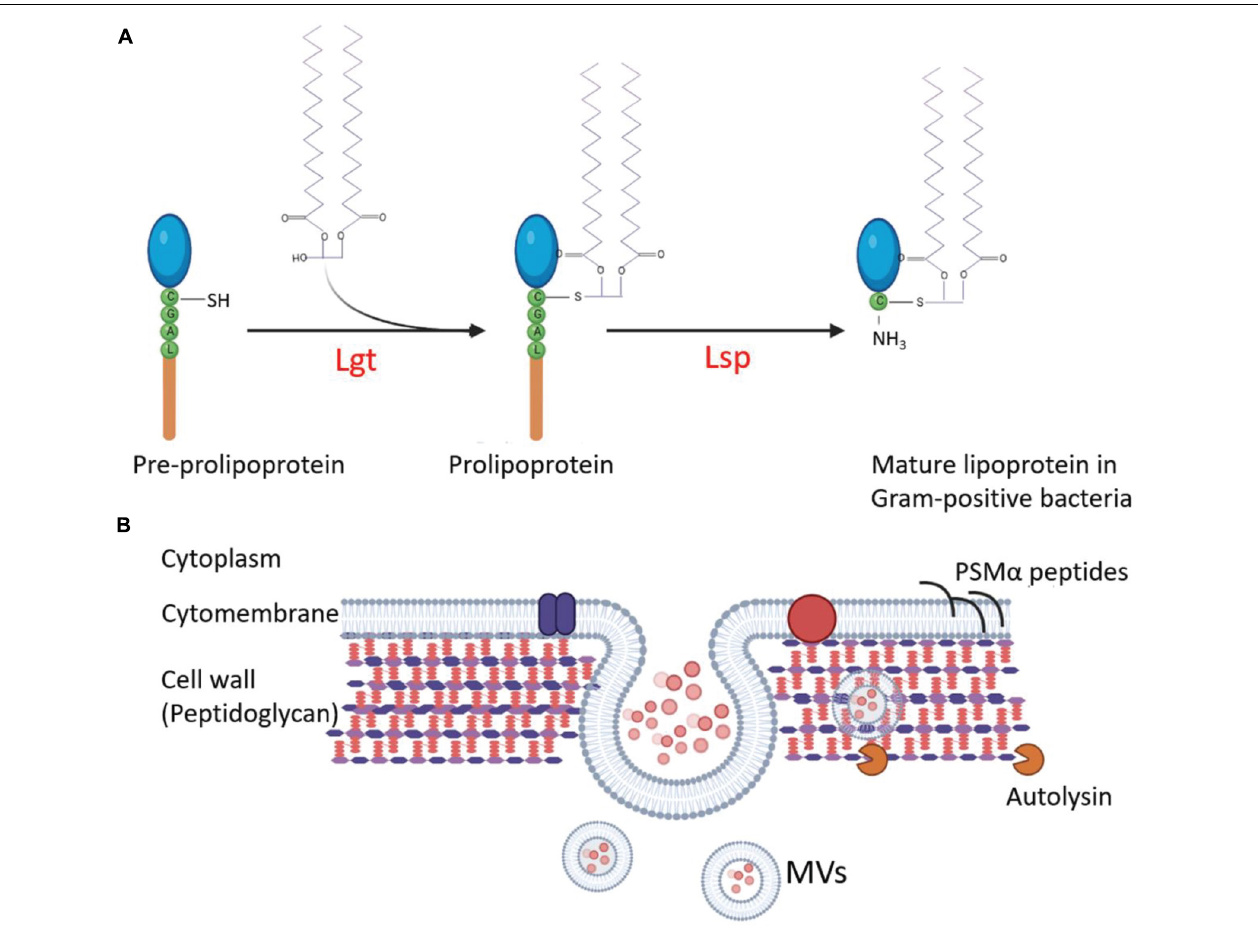
FIGURE 2 | Regulation of the MV production in G + bacteria. (A) Interference of lipoprotein maturation increases MV production. During lipoprotein maturation of G + bacteria, the sulfhydryl group of prolipoprotein cysteine is modified and lipidated by lipoprotein diacylglyceryl transferase (Lgt) and then the lipoprotein signal peptidase (Lsp) cleaves the signal peptide to make cysteine a new amino terminal residue to form mature lipoproteins. Knocking out of lgt increases MV production of the S. aureus mutant. (B) The strategies involved in the regulation of MV production in S. aureus . The MVs are produced from the plasma membrane of S. aureus , and staphylococcal lipoproteins can be mobilized from the cell membrane to increase the fluidity of the membrane and promote MV formation. At the same time, MVs must traverse the highly cross-linked peptidoglycan layer to release. The degradation of the peptidoglycan layer or the reduction of cross-linking promotes MV yield. Autolysins, such as Sle1, promote MV release by hydrolyzing peptidoglycan of S. aureus cells. The circle dots colored with diverse pink in the lumen of MVs represent bacterial proteins, DNA, and